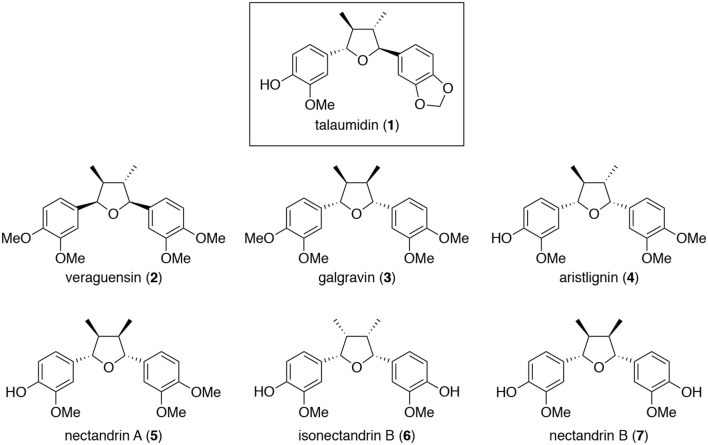
Structures of talaumidin (1) and analogs 2–7 (Zhai et al., 2005).